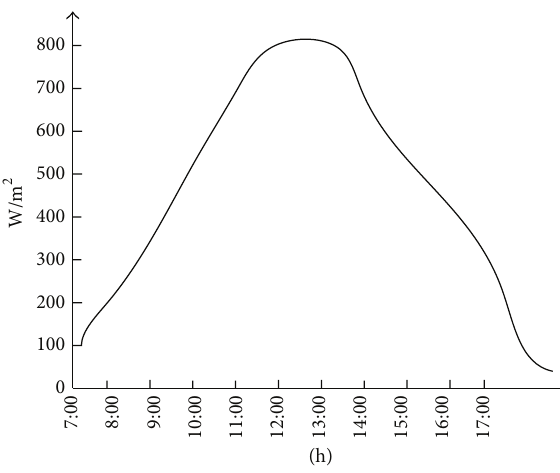
Figure 6: Typical solar irradiance curve in north